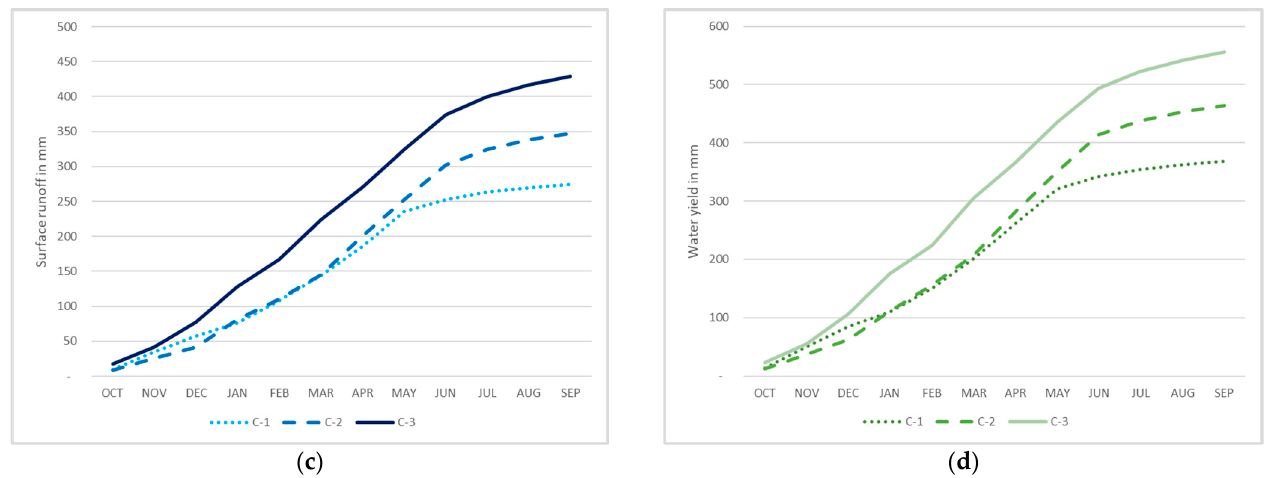
Figure 8. Cumulative water balance monthly components, on water year basis, per configuration period for ( a ) precipitation, ( b ) actual evapotranspiration, ( c ) surface runoff, and ( d ) produced water yield. All numbers are in mm. Table 5. Annual average water balance ratios among different hydrological cycle parameters based on SWAT outputs for all configuration